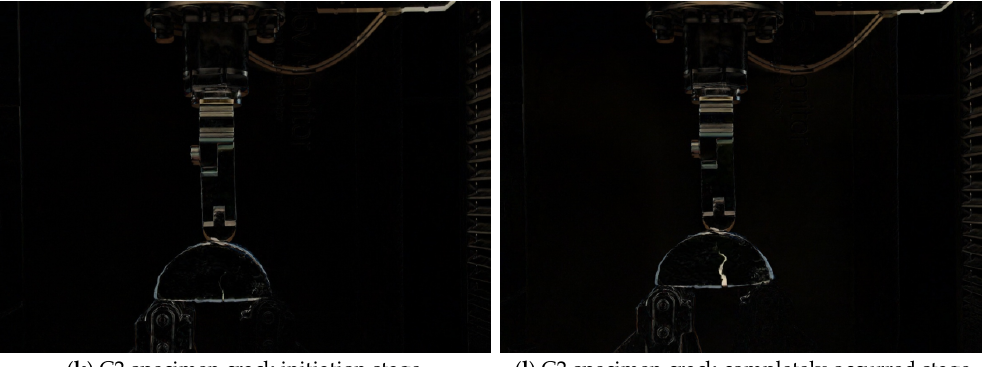
Figure 6. The damage process of the unopened SCB specimen.